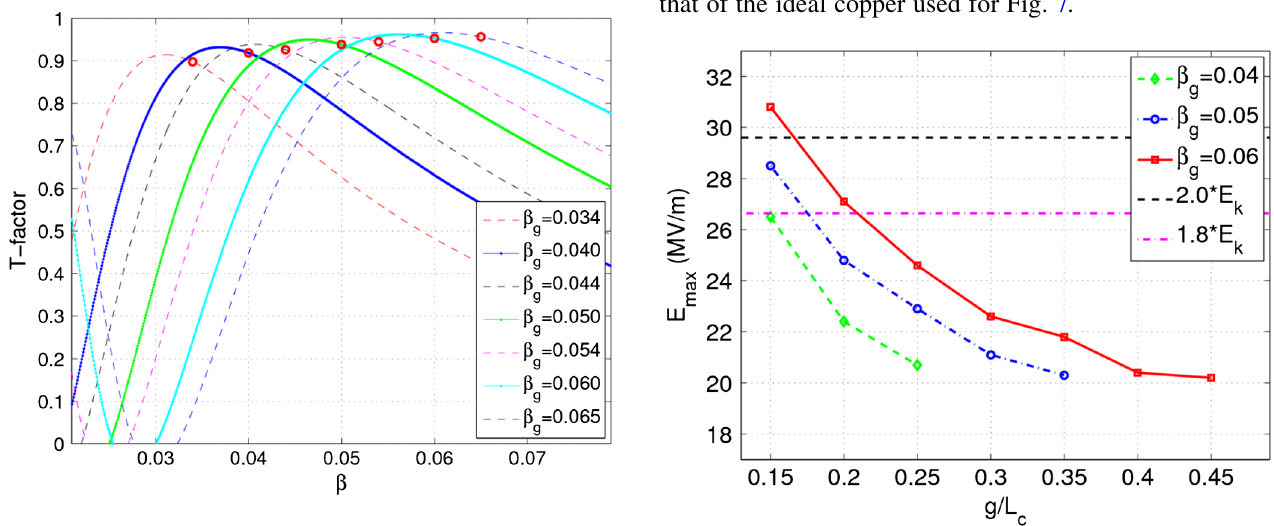
DTs.FIG. 5. Transit-time factors of a few IH structures with vanes (defined by the cavity design velocity (cid:1) velocity (cid:1)